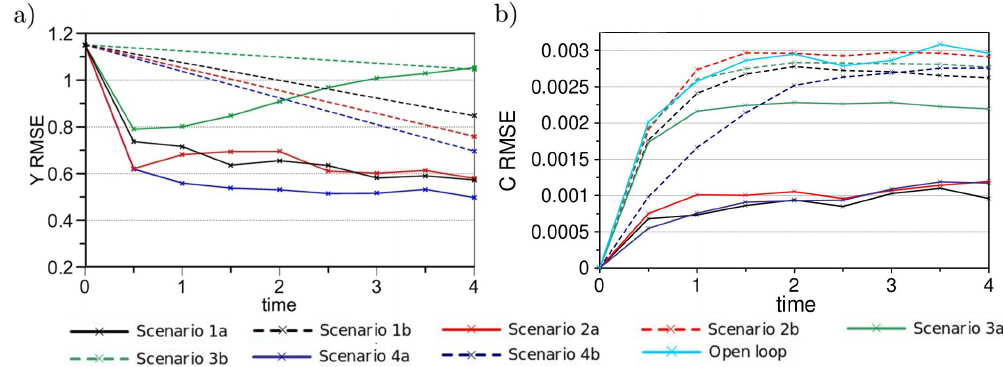
Fig. 10. Root mean square error of (a) the retrieved log-transformed hydraulic conductivity field and (b) the concentration distribution in the retrieved field for the all scenarios.